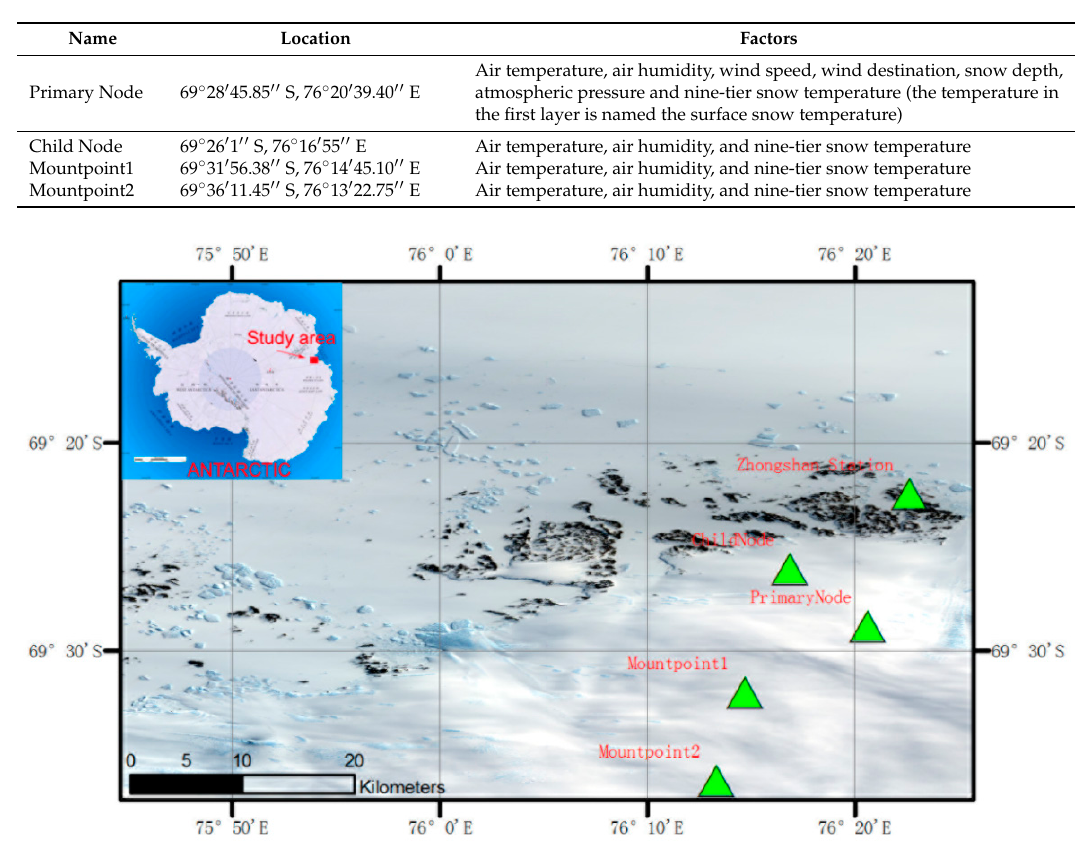
Table 2. The installation location of the wireless sensor network devices.